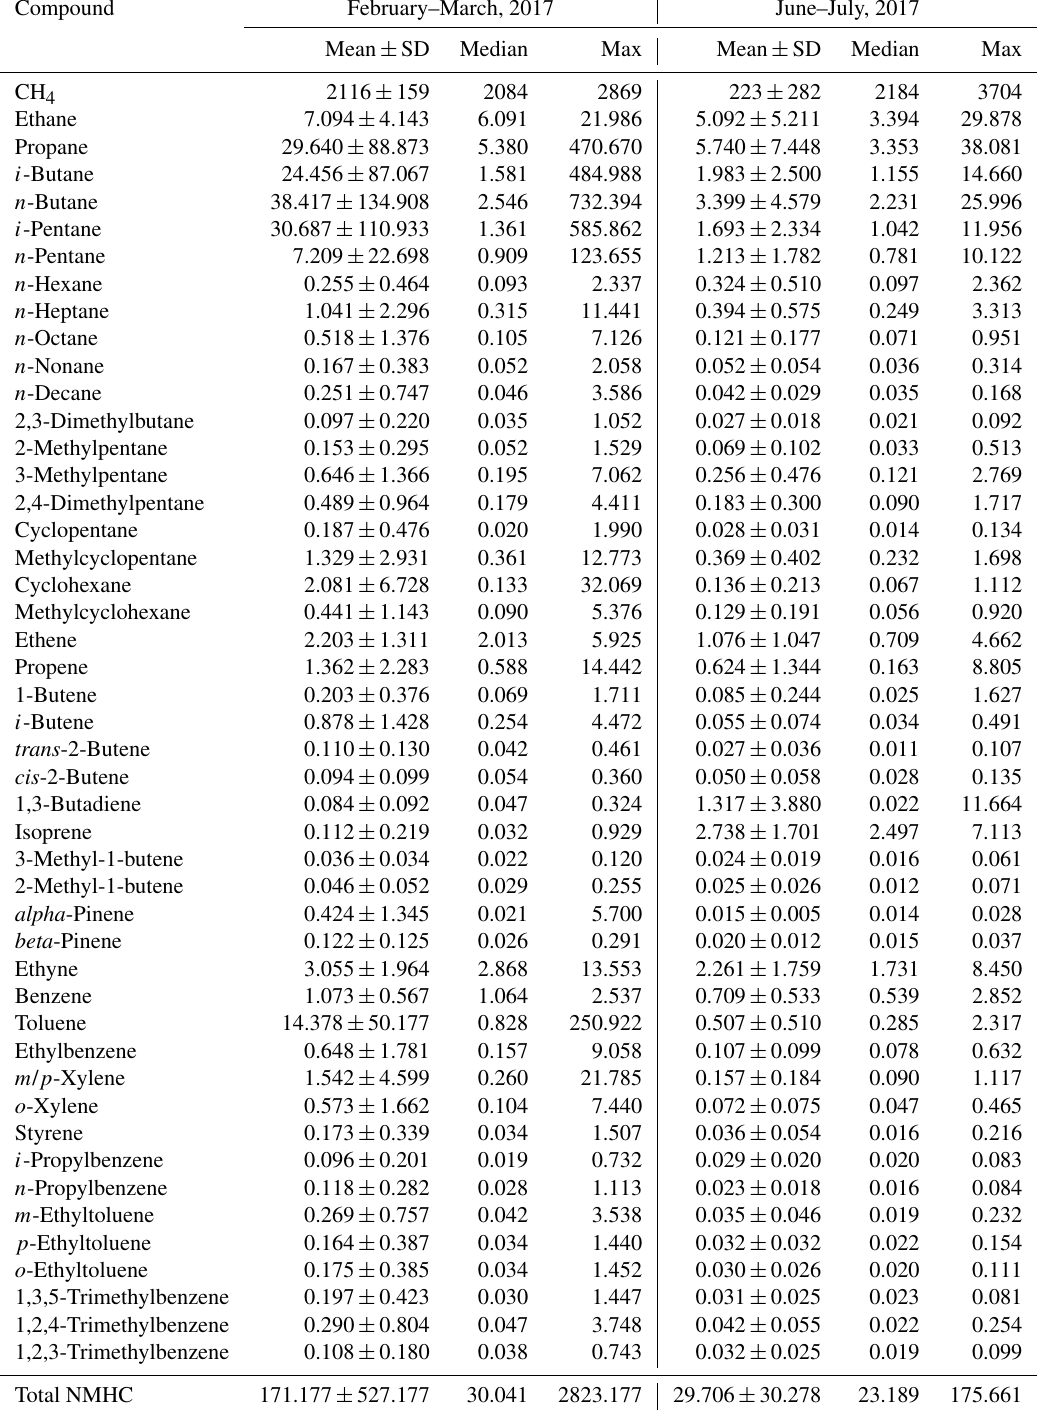
Table 2. Descriptive statistics of measured VOC concentrations at the rural site in the YelRD